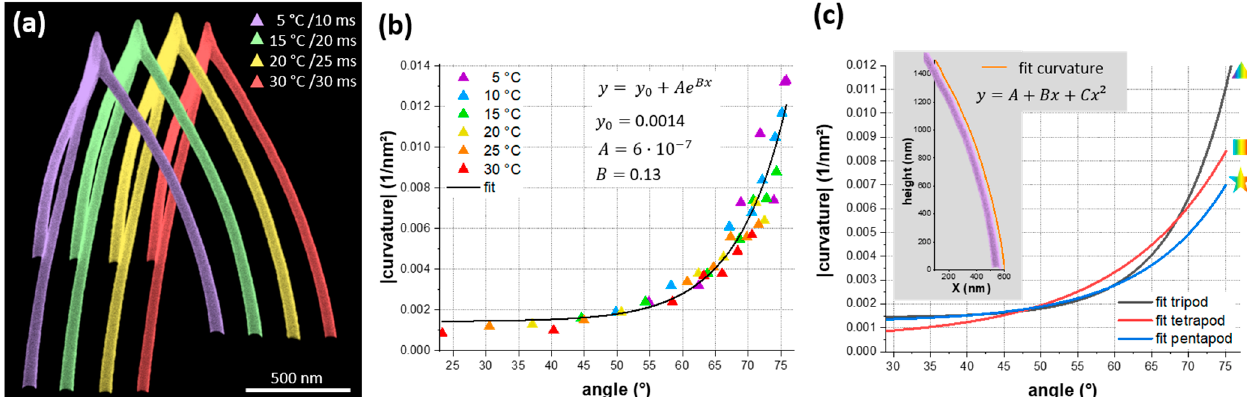
Figure 4. Shape quality and wire curvature. ( a ) Collage of 4 tripods with similar heights (and angles) fabricated at T S of 5 ◦ C, 15 ◦ C, 20 ◦ C and 30 ◦ C with dwell times of 10 ms, 20 ms, 25 ms and 30 ms, respectively, revealing high shape stability even at low temperatures. ( b ) Absolute curvature values for tripods fabricated at different T S (color coded) together with a common exponential fit function. ( c ) Absolute curvature fits for tri-, tetra- and pentapods. The inset representatively shows a real tripod leg together with the corresponding quadratic polynomial fit function to justify that here used modelling.